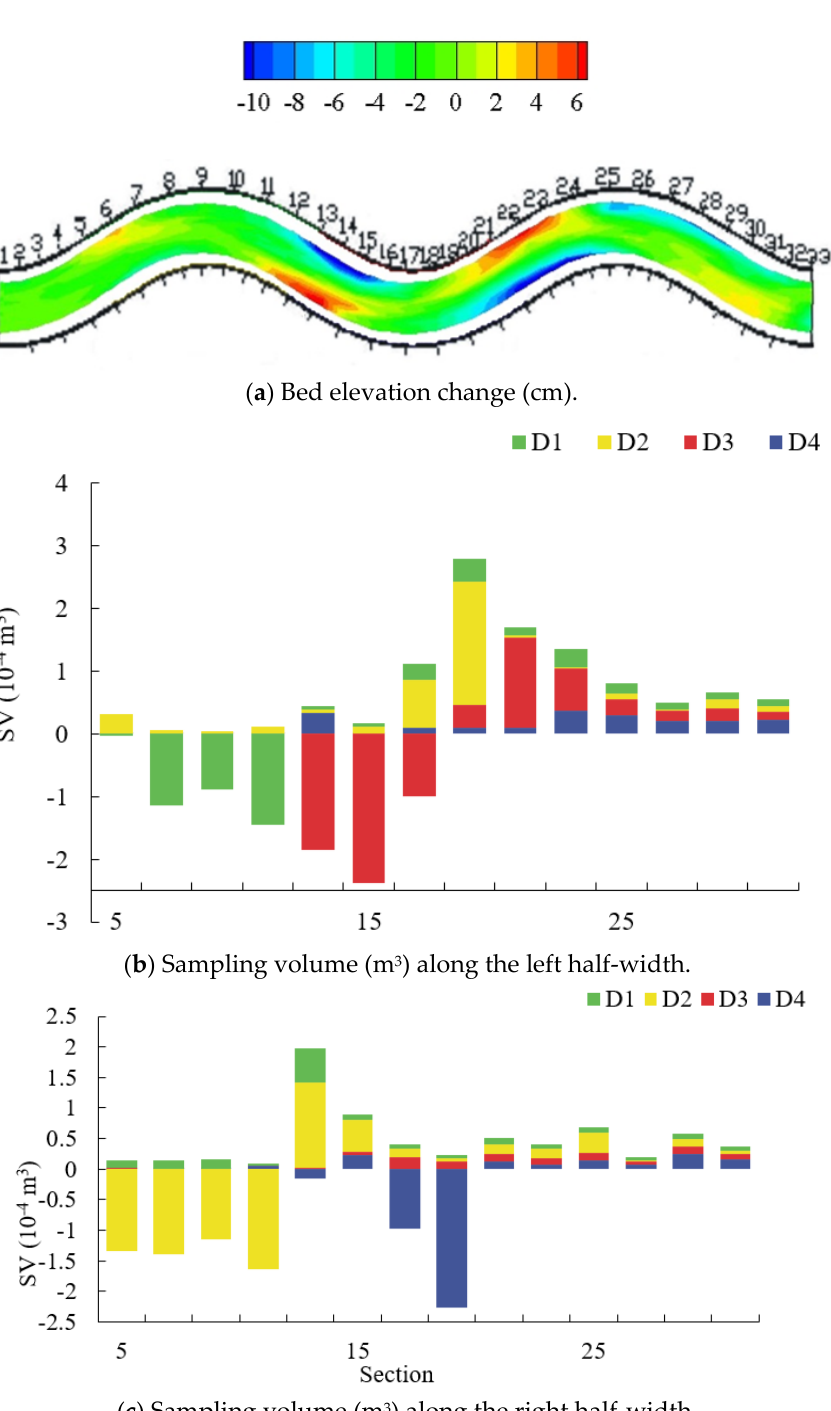
Figure 3. ( a ) Bed elevation change (units are cm, Run 30/1, flow from left to right). ( b ) Sample volume (unit: m 3 ) of grains D 1 , D 2 , D 3 , D 4 at each section along the left bank. ( c ) Sample volume (unit: m 3 ) of grains D 1 , D 2 , D 3 , D 4 at each section along the right bank. D 1 , D 2 , D 3 , D 4 grains are represented by green, yellow, red, and cyan colors, respectively.